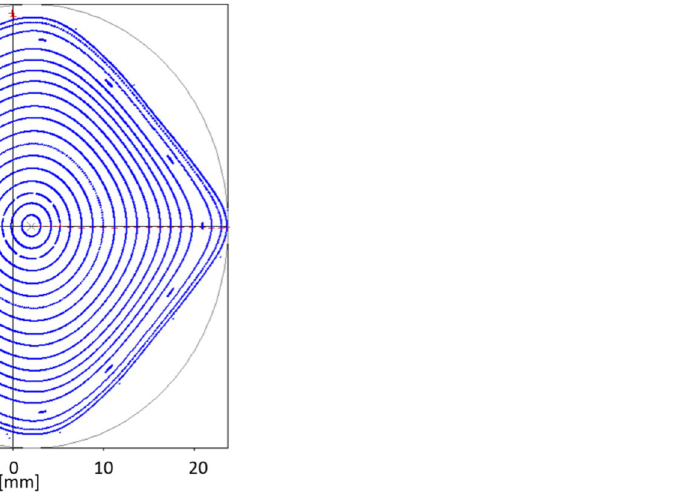
Figure 15. Structure of phase space ( x , p x ) for δ = 1% when various initial conditions are used for particle tracking simulation in OPA, using the set of sextupoles { S 2 }